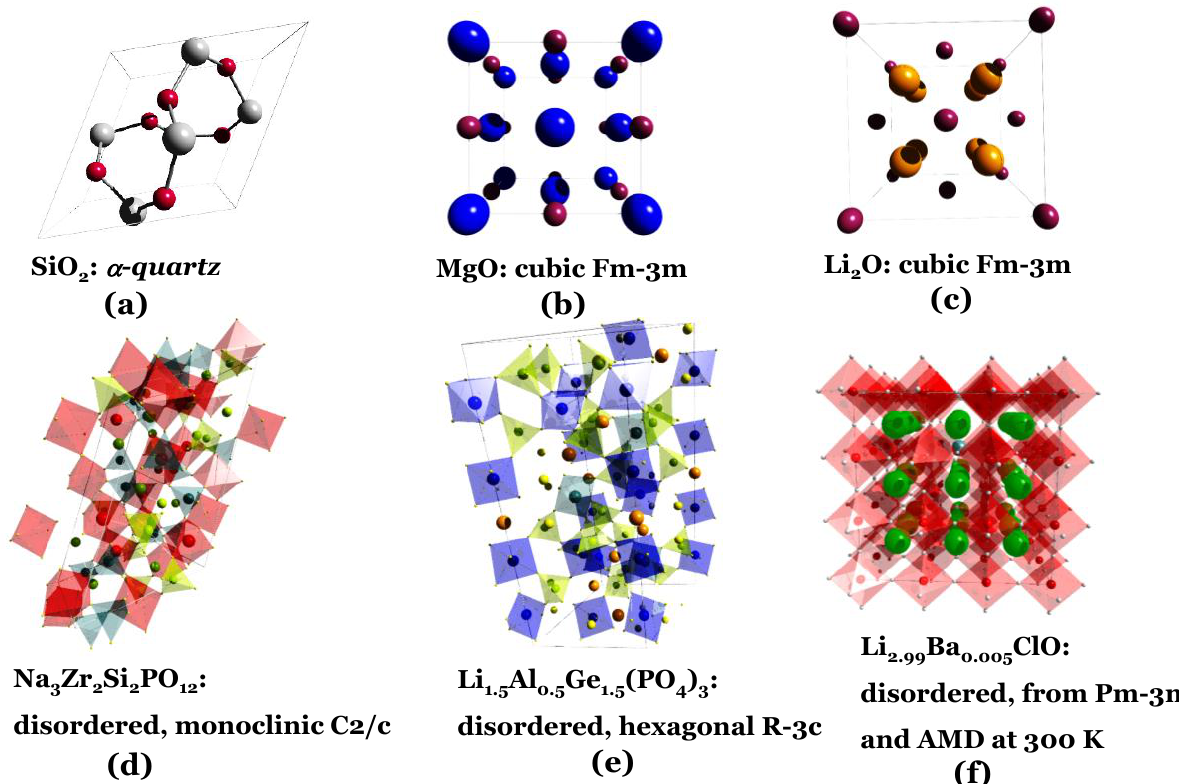
Figure 1. Crystal structures for the studied insulators. Dielectric oxides : ( a ) SiO 2 trapezohedral, P3221 (sg# 154); red spheres: O; ( b ) MgO cubic, Fm-3m, (sg# 225); wine-red spheres: O; ( c ) Li 2 O cubic, Fm-3m, (sg# 225); wine-red spheres: O; dielectric solid electrolyte : ( d ) room temperature Na 3 Zr 2 Si 2 PO 12 – NASICON, monoclinic, C2/c (sg#15); octahedral: ZrO 6 ; tetrahedral: PO 4 /SiO 4 sharing common corners; ( e ) Li 1.5 Al 0.5 Ge 1.5 (PO 4 ) 3 –LAGP, rhombohedral, R-3c (sg#167); octahedral: AlO 6 /GeO 6 ; tetrahedral: PO 4 ; orange spheres: Li; yellow spheres: O. ( f ) Li 2.99 Ba 0.005 ClO–Li + -glass optimized structure using ab initio molecular dynamics at 300 K from the initial cubic structure Pm-3m (sg# 221). octahedral: OLi 6 ; green-blue (small) sphere: Ba; green spheres: Cl. Note: the dielectrics were chosen due to their applications and relative work functions : WF(SiO 2 ) > WF(Cu) > WF(Al), WF(Cu) > WF(Al) > WF(MgO), and WF(Cu) > WF(Li 2 O) > WF(Al).